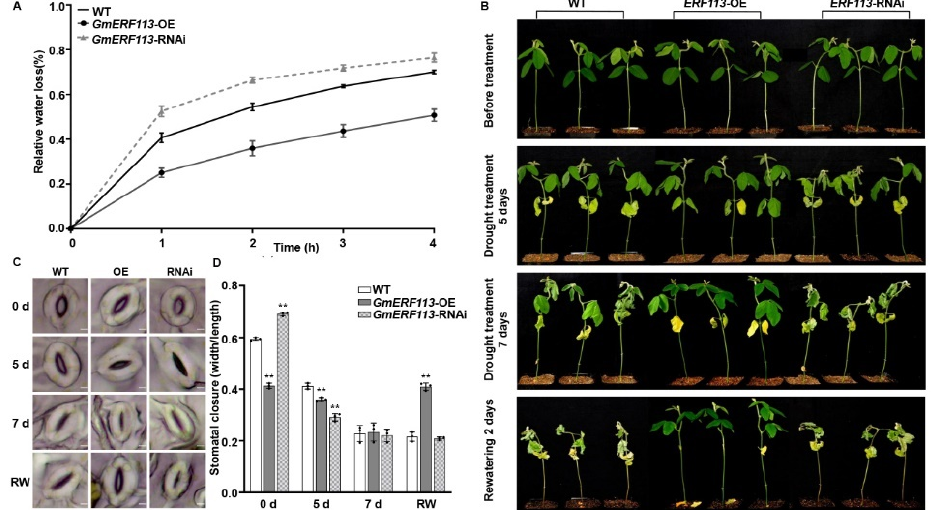
Figure 2. GmERF113 is a positive regulator of plant response to drought. ( A ) The relative water loss of the detached leaves in wild-type (WT) plants, GmERF113- OE, and GmERF113- RNAi transgenic soybean plants. The second trifoliate leaves of soybean seedlings at the V3 stage were cut which were weighed every hour. The experiment was carried out in three biological replicates, each with three technical replicates. The bars indicate the standard deviation of the mean. ( B ) Phenotypes of WT, GmERF113- OE, and GmERF113- RNAi soybean plants that were exposed to drought stress for 0, 5, and 7 days and re-watered for 2 days. ( C , D ) Stomatal apertures of the second trifoliate leaves of WT, GmERF113- OE, and GmERF113- RNAi soybean plants that were treated with drought for 0, 5, or 7 d and re-watered for 2 days ( C ), and statistical analysis of the stomatal apertures of each line (bars = 20 μ m) ( D ). The experiment was performed on three biological replicates, each with three technical replicates, and was statistically analyzed using Student’s t -test (** P < 0.01). The bars indicate the standard deviation of the mean.